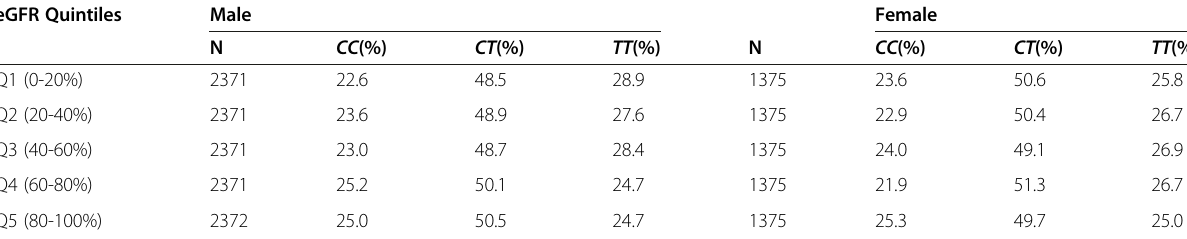
Table 3 MTHFR C677T genotype frequencies in eGFR quintiles eGFR Quintiles